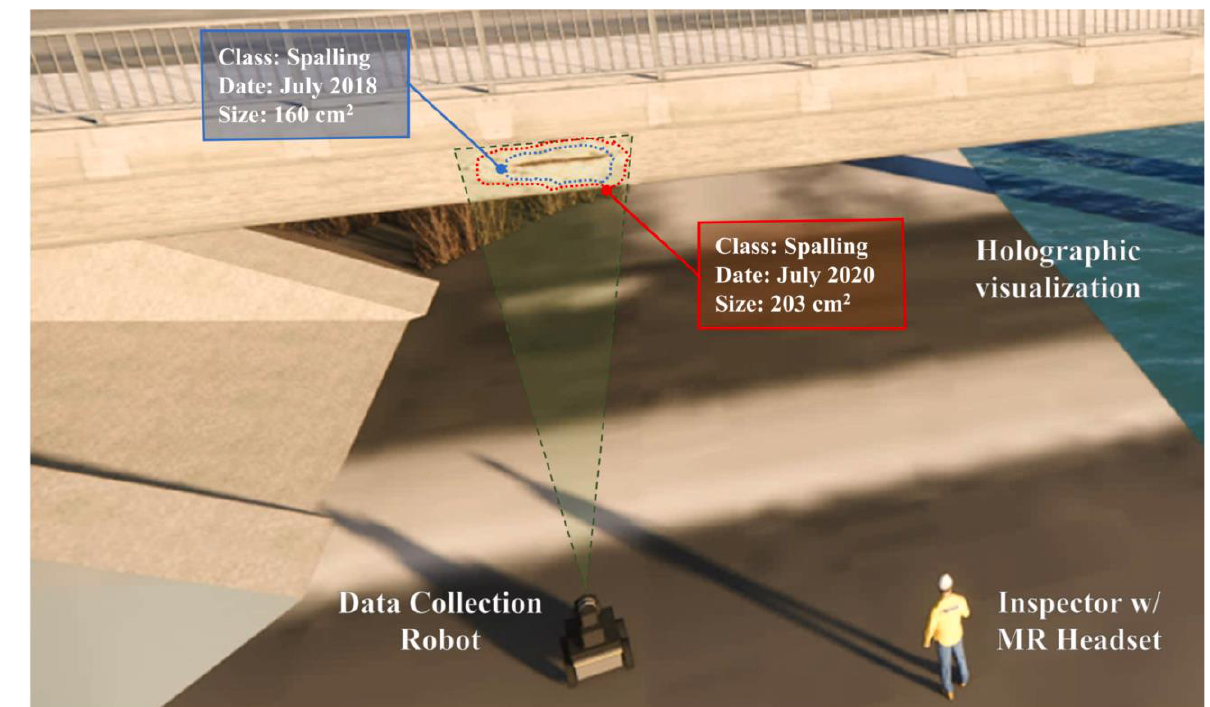
Figure 23. Descriptive visualization of HMCI for bridge inspection [131].